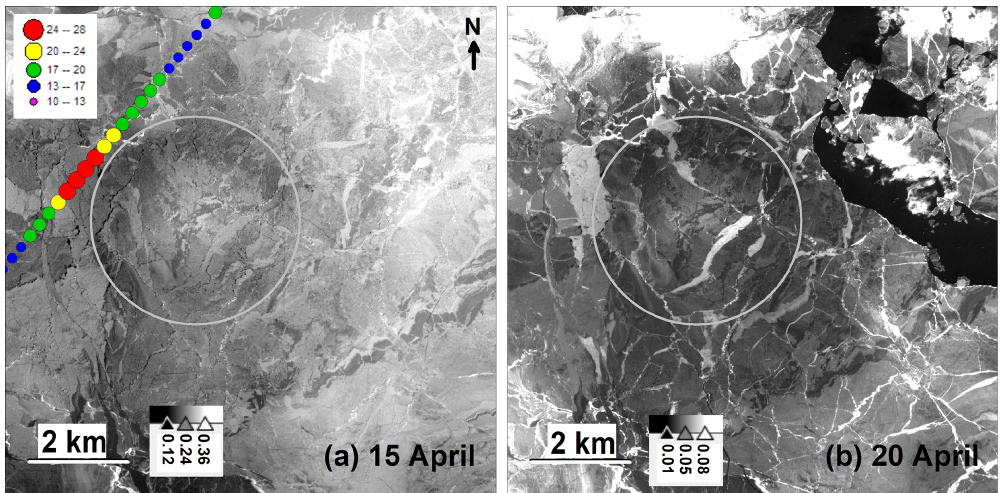
Figure 5. Changes in ice cover in April 2020. on satellite images. (a) 15 April and (b) 20 April, Sentinel-2B, red band. Grey palette – reflectance units (digital numbers). In the image for 15 April backscatter values (dB, coloured dots) for the Jason-3 track 79, cycle 154 (16 April 2020, 22h local time, GMT + 8h) are also shown. Grey circle – outer limit of ice ring as defined from image on 15 April. White linear features – cracks; black areas – open water. All satellite images in Figs. 5, 7 and 9 are to scale and show exactly the same region. Colour stretching is different for each image to enhance the contrast. Projection UTM 48N.